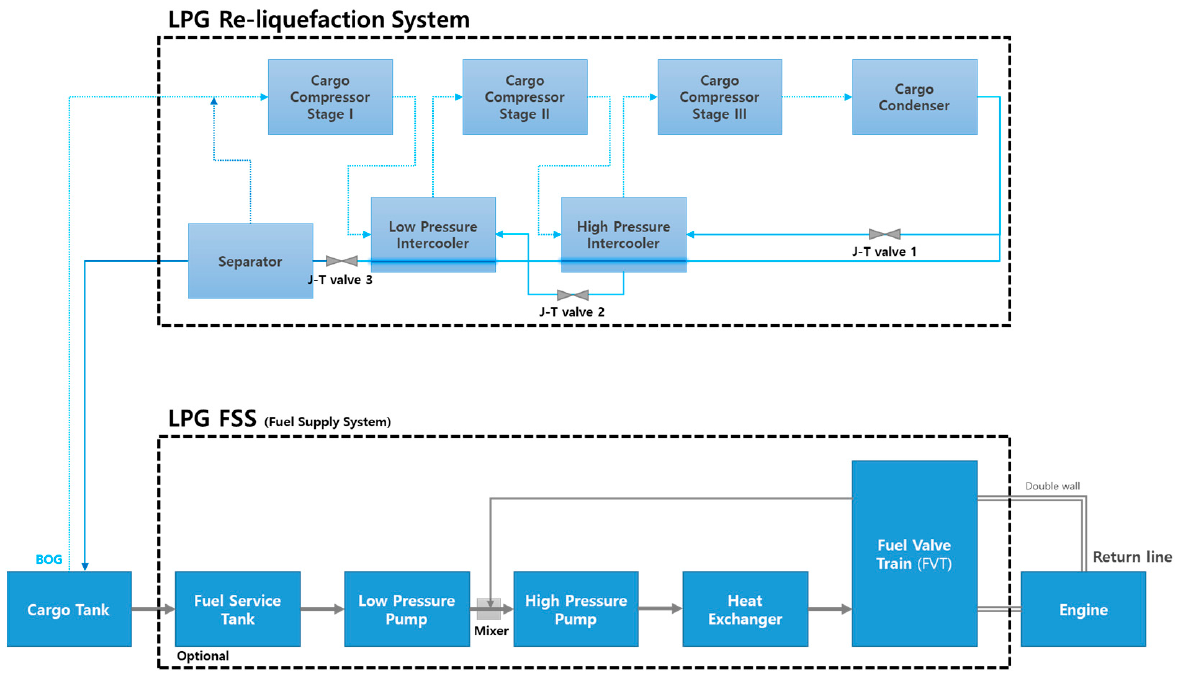
Figure 2. Block diagram of re-liquefaction and fuel supply systems in conventional LPG-fuelled LPG carrier.